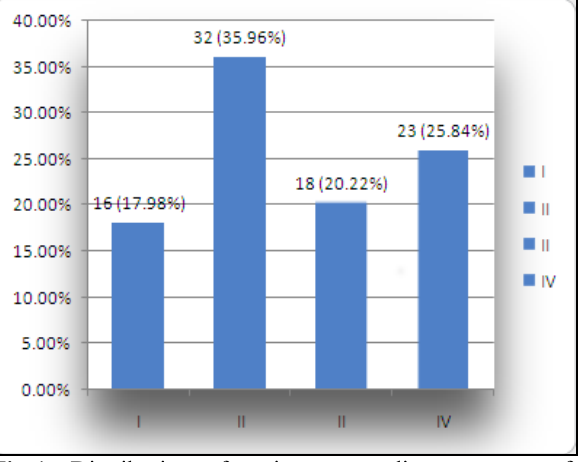
Fig-1: Distribution of patients according to stage of carcinoma (n=89)